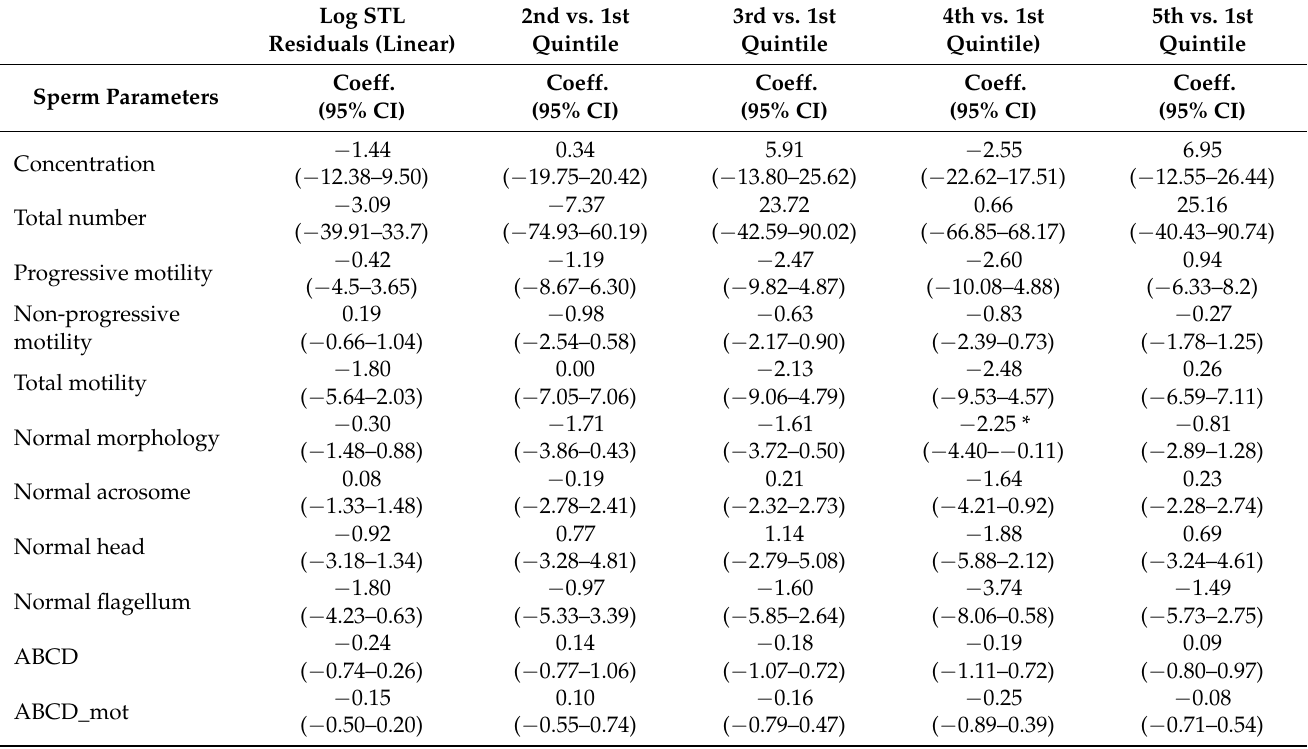
Table 3. Association between sperm telomere length (STL) and sperm